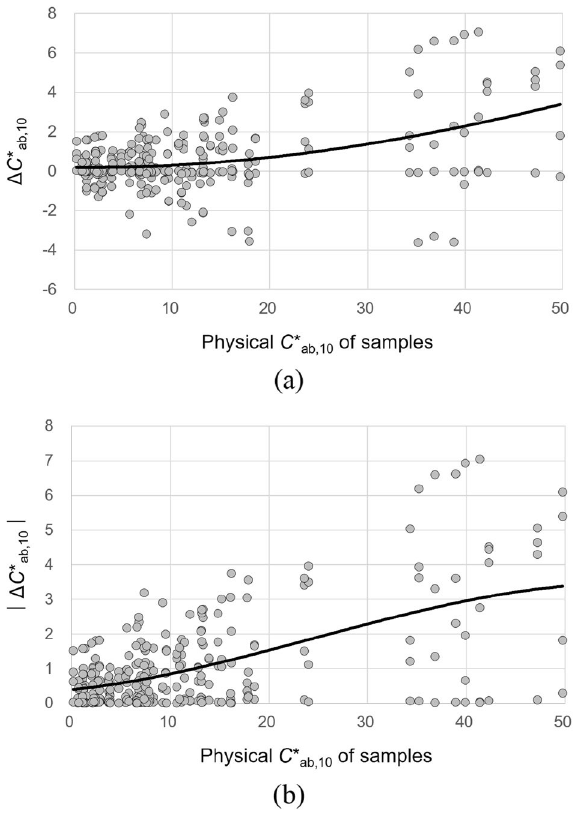
Figure 14. Effect of the physical C * ab,10 of samples on their chroma appearance change, ( a ) Δ C * ab,10 and ( b ) (cid:31) (cid:31) (cid:31) (cid:31) C ∗ ab ,10 (cid:31) , under illuminants. (Δ C * ab,10 = C * A under the illuminant − spectrophotometrically measured C * ab,10 ).